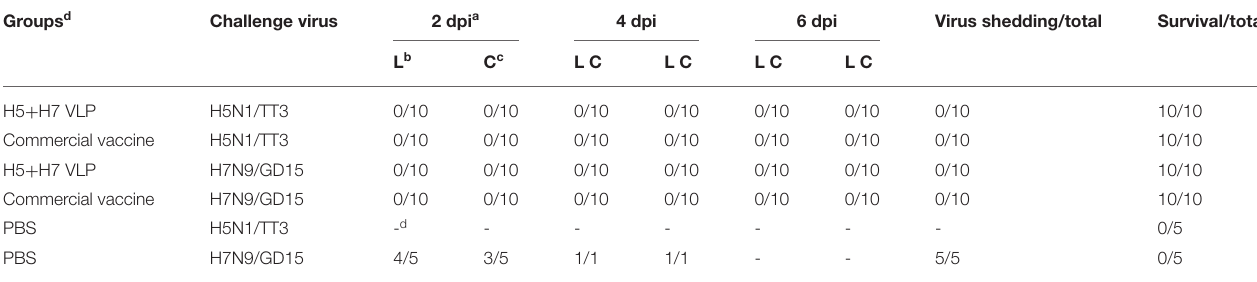
TABLE 1 | Virus shedding of the birds challenged by H5N1 or H7N9 virus. Groups d Challenge